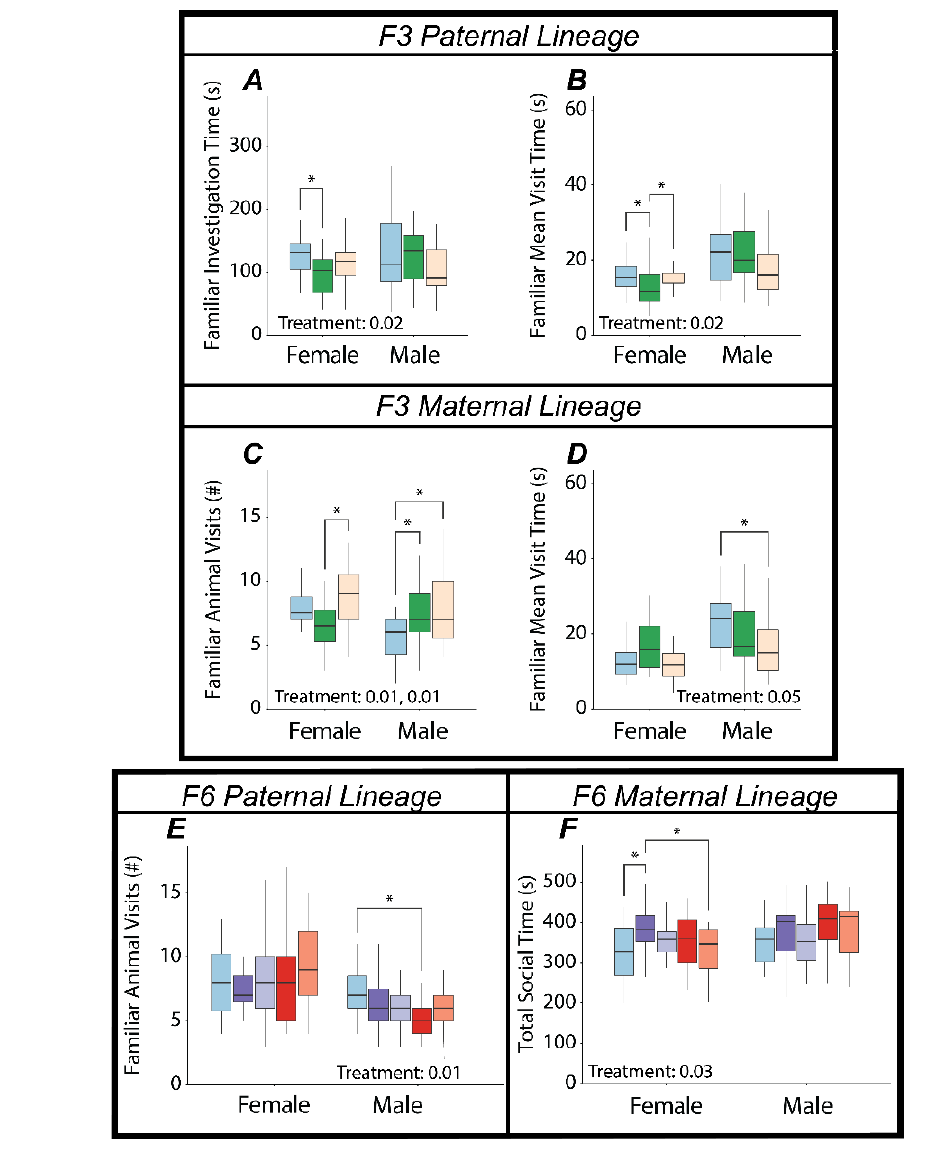
Figure 7. Aspects of social interaction dynamics in the test for social novelty are graphed as box and whisker plots (minimum, 25% quartile, median, 75% quartile, and maximum). Main effects of treatment within sex and lineage were determined by a one-way ANOVA within each sex and lineage, and indicated for p < 0.05. Significant post hoc results as determined by Tukey HSD and appropriately adjusted for multiple comparisons are indicated with bars connecting the respective groups (* <0.05). Shown are significant effects for the F3 paternal ( A , B ) and maternal ( C , D ) lineages, and F6 paternal ( E ) and maternal ( F ) lineages.